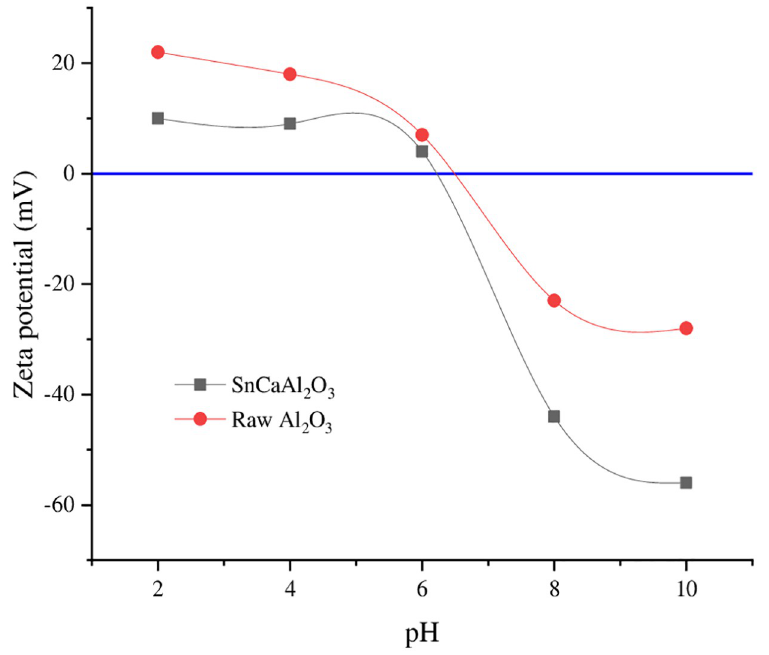
Fig 8. Zeta potential of Al 2 O 3 and SnCaAl 2 O 3